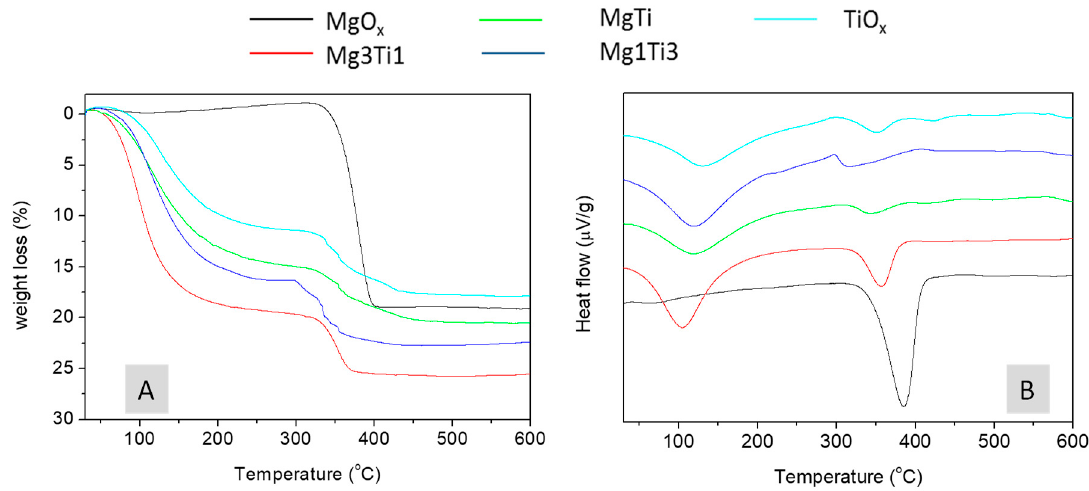
Figure 1. TG-DTA profiles of the precursor gels of the catalysts based on ZrO x and TiO x . Weight loss ( A ) and heat flow ( B ) profiles.